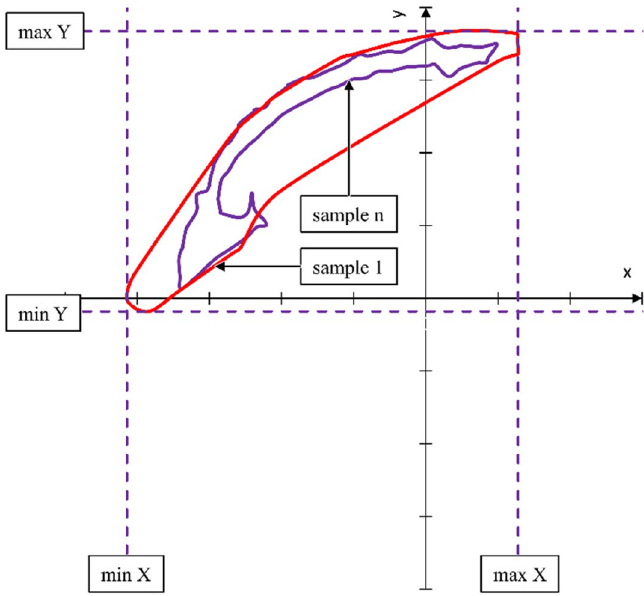
Figure 8. Graph representing hand position during wheelchair propulsion, where: sample 1 and sample n are the outline of the analyzed measurement sample consisting of five full propulsion